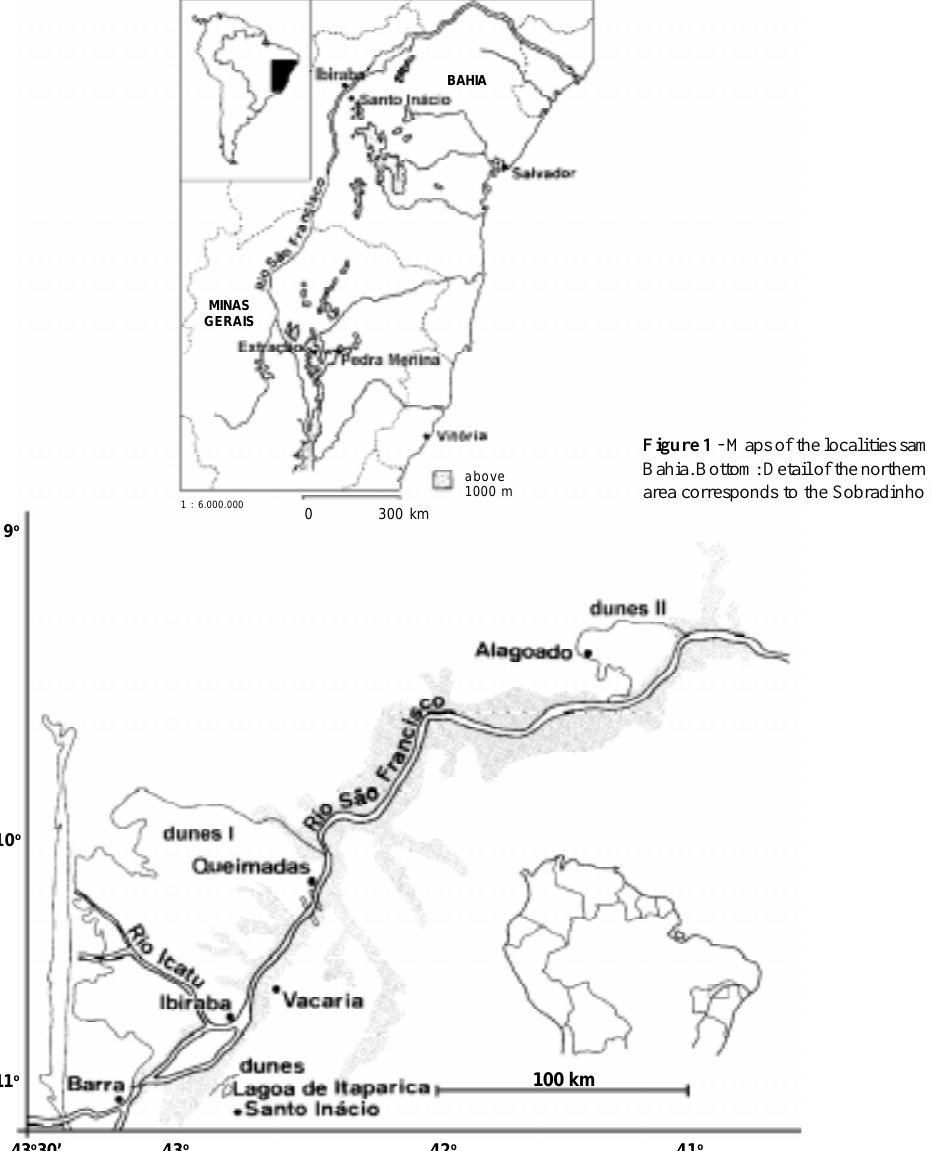
Figure 1 - Maps of the localities sampled. Top: Region of Minas Gerais and Bahia. Bottom: Detail of the northern region of the State of Bahia (the stippled area corresponds to the Sobradinho hydroelectric dam